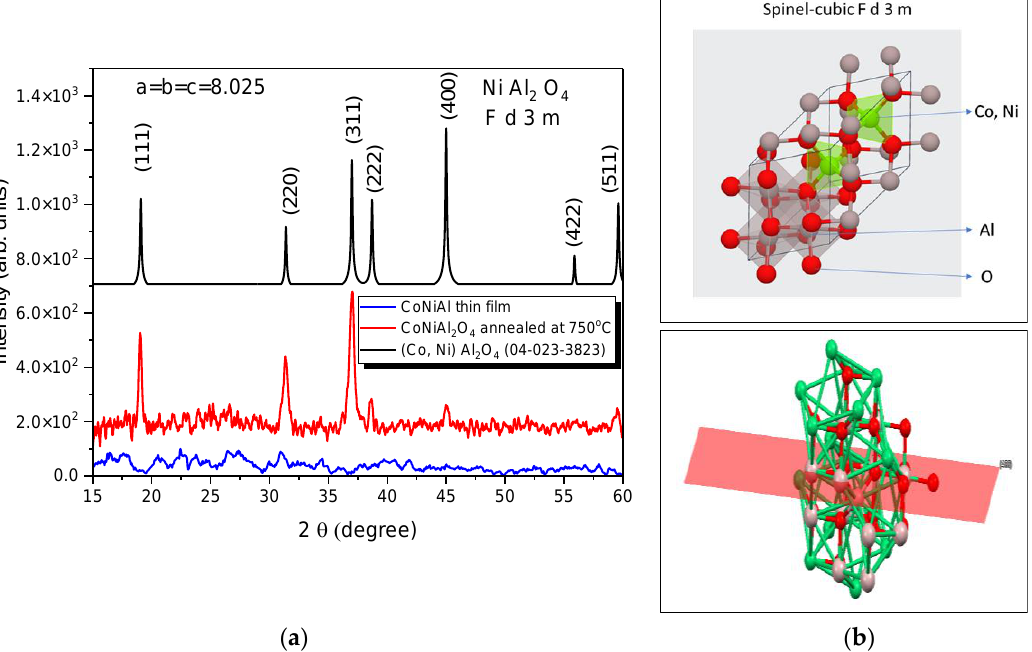
Figure 2. X-ray patterns of initial and annealed films ( a ) and the obtained spinel structure ( b ). Interstitial positions partially occupied by tetrahedral- Co or Ni and octahedral-Al atom ( up ). Distinguishing the normal spinels is the perpendicular growth of the (400) plane from 45.04° as seen in the XRD results ( down ).